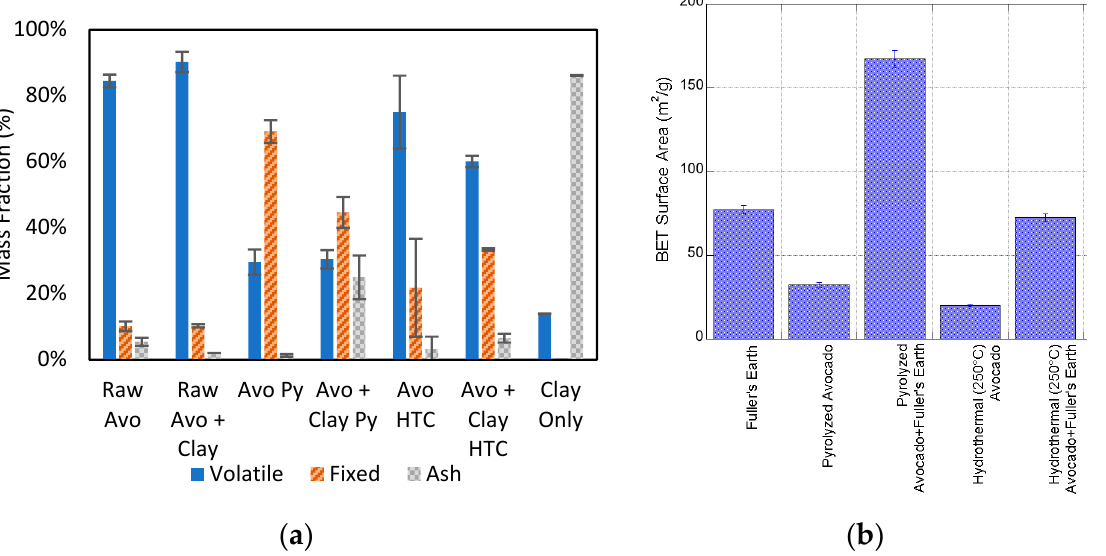
Figure 4. Characterization of raw materials, biochars, and hydrochars (error bars indicate one standard deviation) including ( a ) proximate analysis results (clay-free basis) and ( b ) surface area.